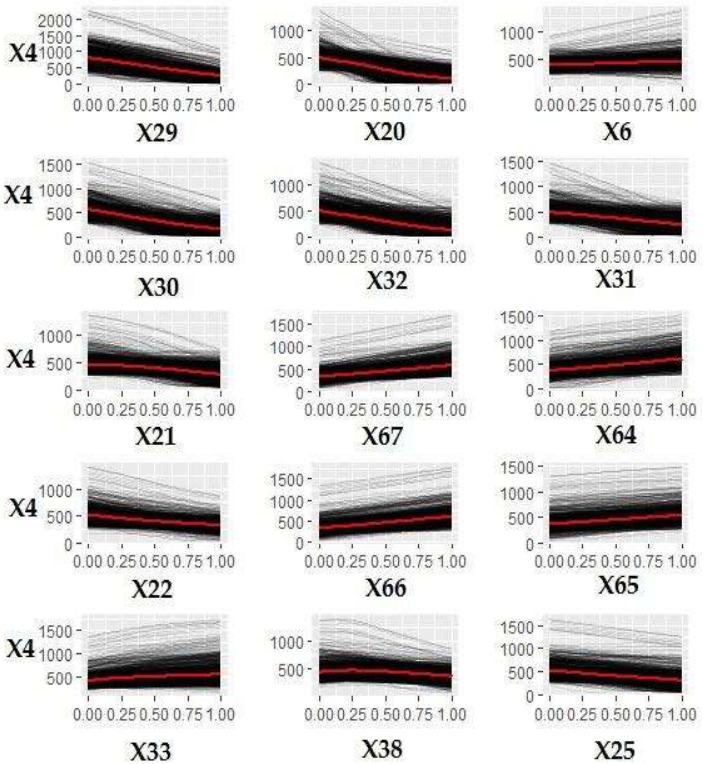
Figure 5. ICE curves of the 15 most influential variables on annual per capita waste production.